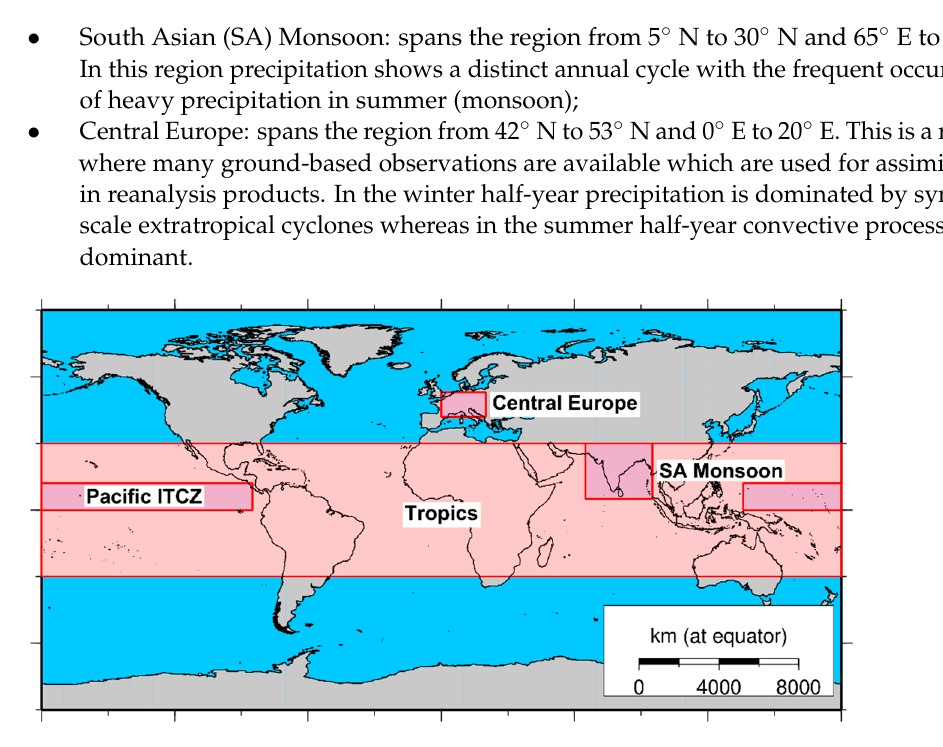
Figure 1. Definition of the geographical regions for which precipitation analyses were performed.